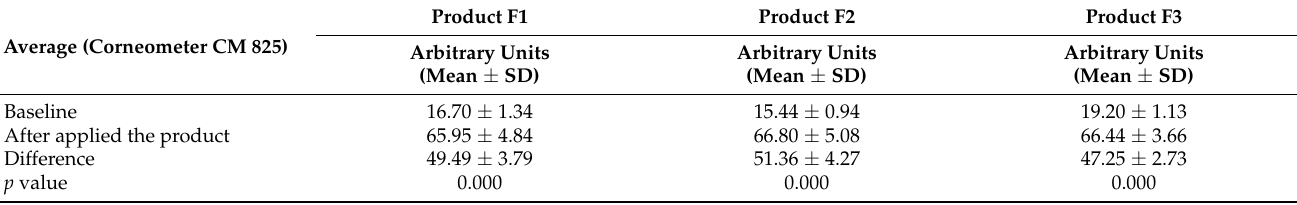
Table 4. Moisture analysis of the developed products and a counter brand liquid crystal